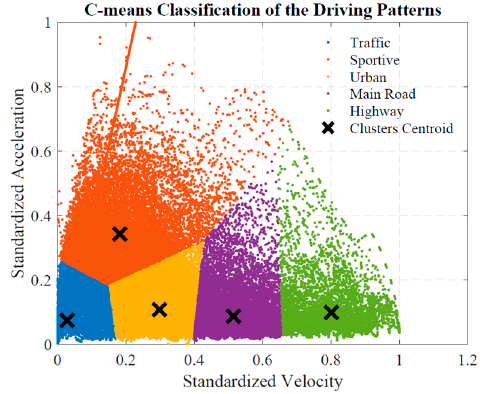
Figure 9. Classification of the driving patterns.